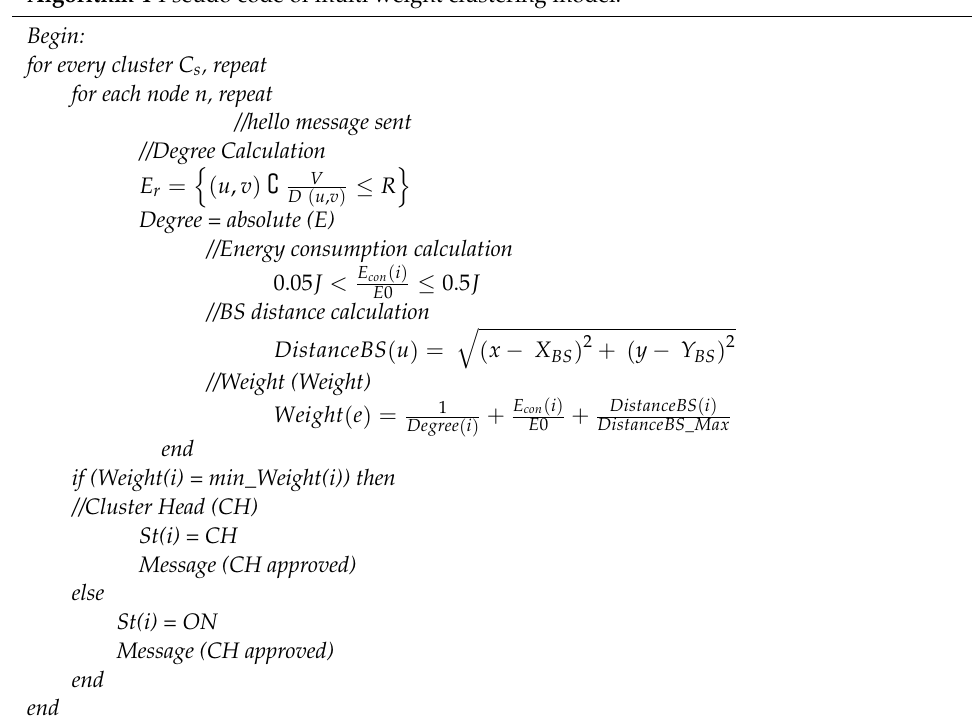
Algorithm 4 -Pseudo code of multi weight clustering